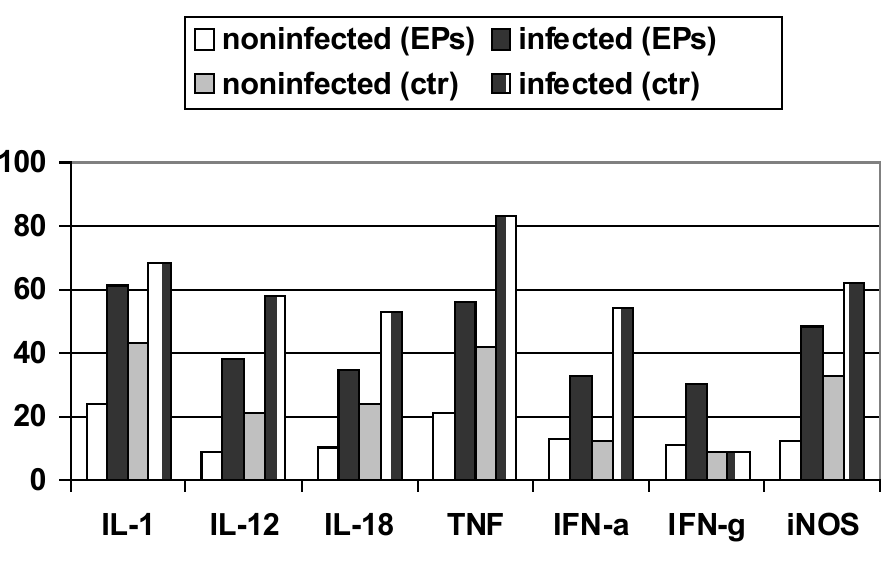
Figure 5. Expression of iNOS and cytokine transcripts in non-infected and in L. major infected RAW 264.7 cells stimulated for 4 h with 50 µg/mL of EPs ® 7630 and LPS/IFN-γ as positive control (ctr). Results are shown relative to hypoxanthine-guanine-phosphoribosyl transferase mRNA, defined as